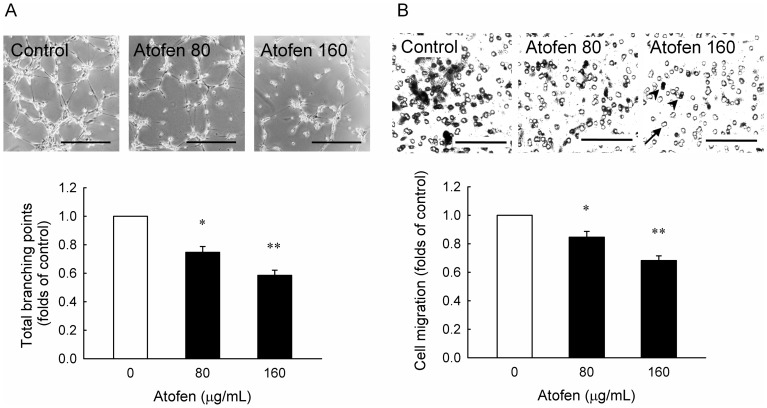
Iron inhibited tube formation and migratory capacity in HAECs.HAECs were treated with ferric chloride hexahydrate (Atofen) for 4 hours in tube formation (A) and 12 hours in cell migration (B). Values are expressed as mean ± SEM. Scale bar represents 50 µm in Figure 5A and 30 µm in Figure 5B. The arrowheads indicate migrated endothelial cells and the arrow indicates membrane pore. *P<0.05, **P<0.001 compared with baseline without Atofen treatment, n = 3 in each group. Abbreviations: HAECs, human aortic endothelial cells.